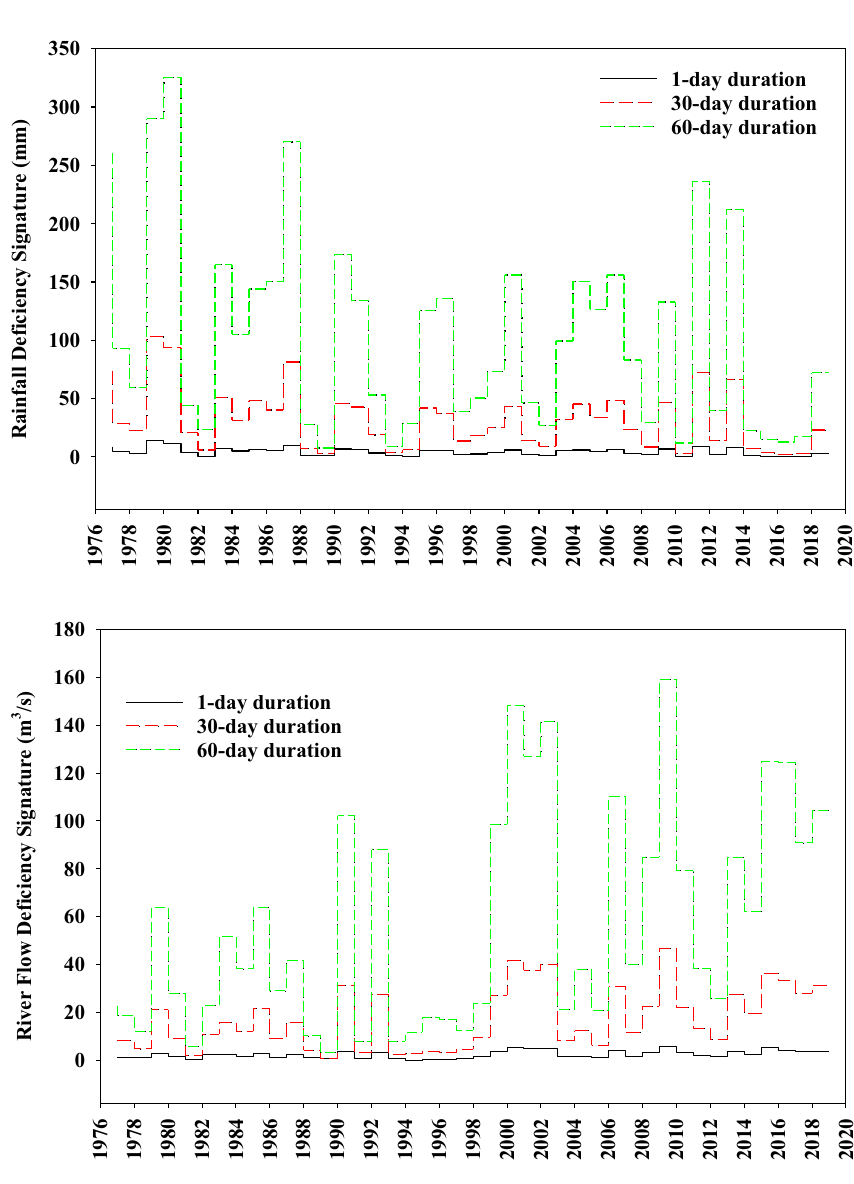
Fig. 4 Results of rainfall deficiency signature at Tapik rain gauge station for 10, 30 and 60-day durations in statistical period of 1977–2019